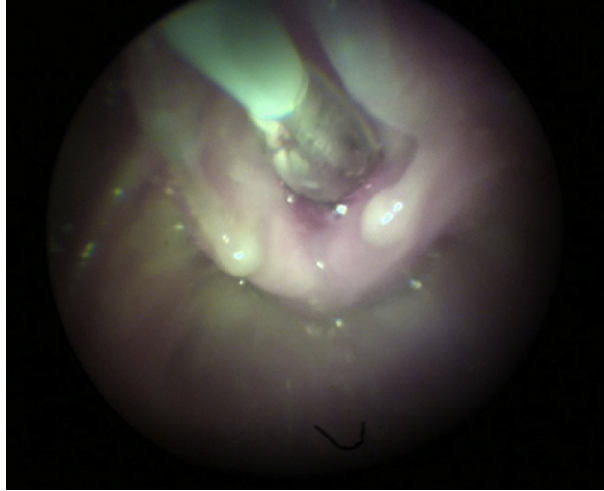
Figure 1 Balloon during dilatation. Child during balloon laryn-